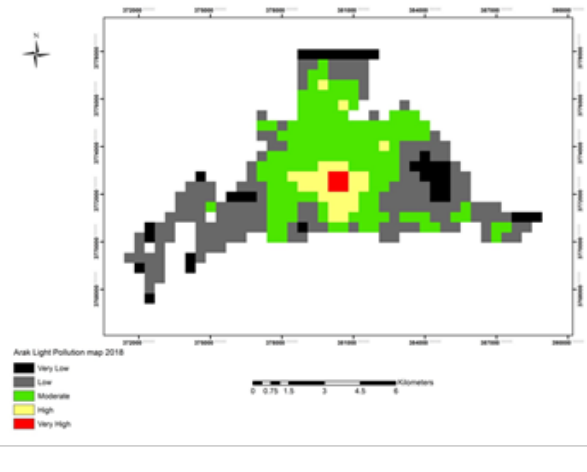
Figure 4. Light pollution map 2018